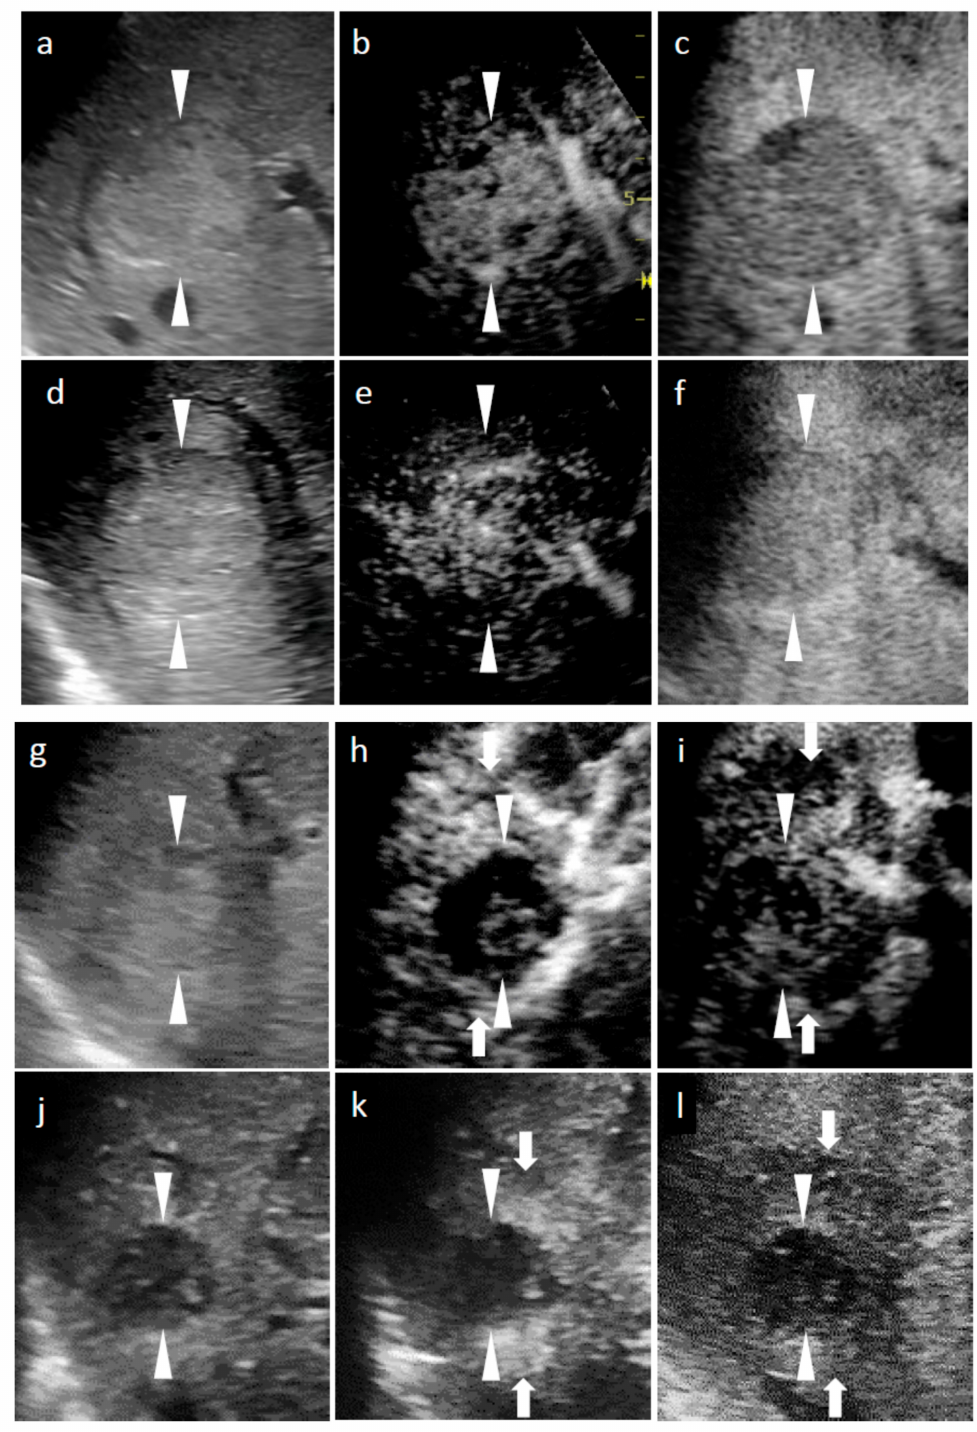
Figure 1. Grayscale ultrasound (US) and contrast-enhanced US with Sonazoid (SCEUS) images, before and after radiotherapy (RT), for a hepatocellular carcinoma (HCC) lesion (maximum diameter: 38 mm) in segment VIII; evaluated as no local recurrence after RT. The patient was unable to undergo punctuation or surgical resection as they took two antiplatelet drugs during the subsequent 6 months of coronary stenting due to an angina attack. After RT, the patient could not receive contrast-enhanced computed tomography (CT), due to progression of chronic kidney disease. ( a – c ) Before RT: A hyperechoic lesion was observed using grayscale US ( a ). This lesion showed hypervascularity during the arterial phase (AP) of